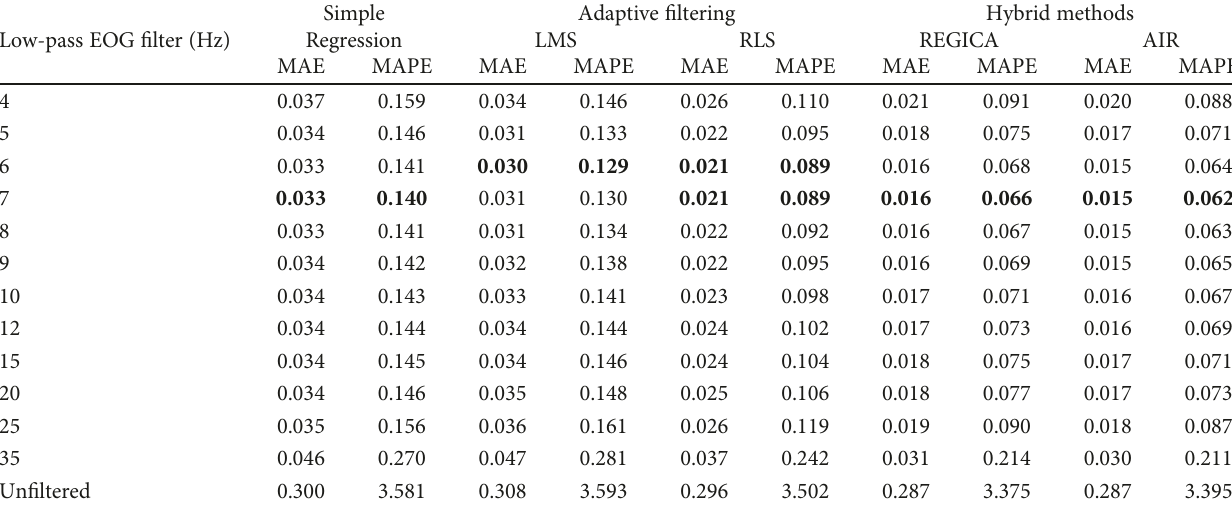
Table 10: Mean absolute error (MAE) and mean absolute percentage error (MAPE) values in gamma frequency band (mean of all EEG channels and mean of all simulated